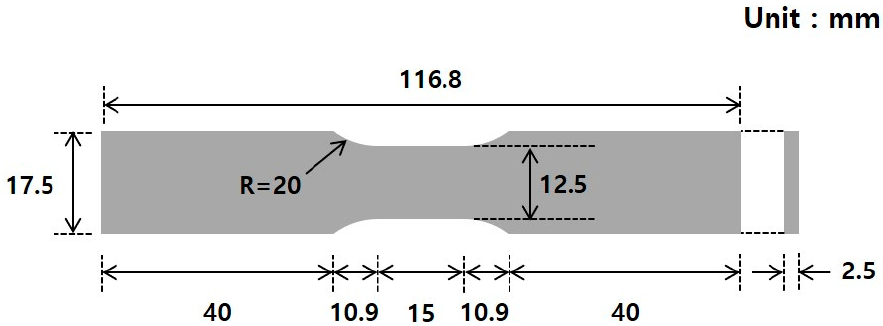
Figure 3. Shape and dimension of fatigue test specimen.